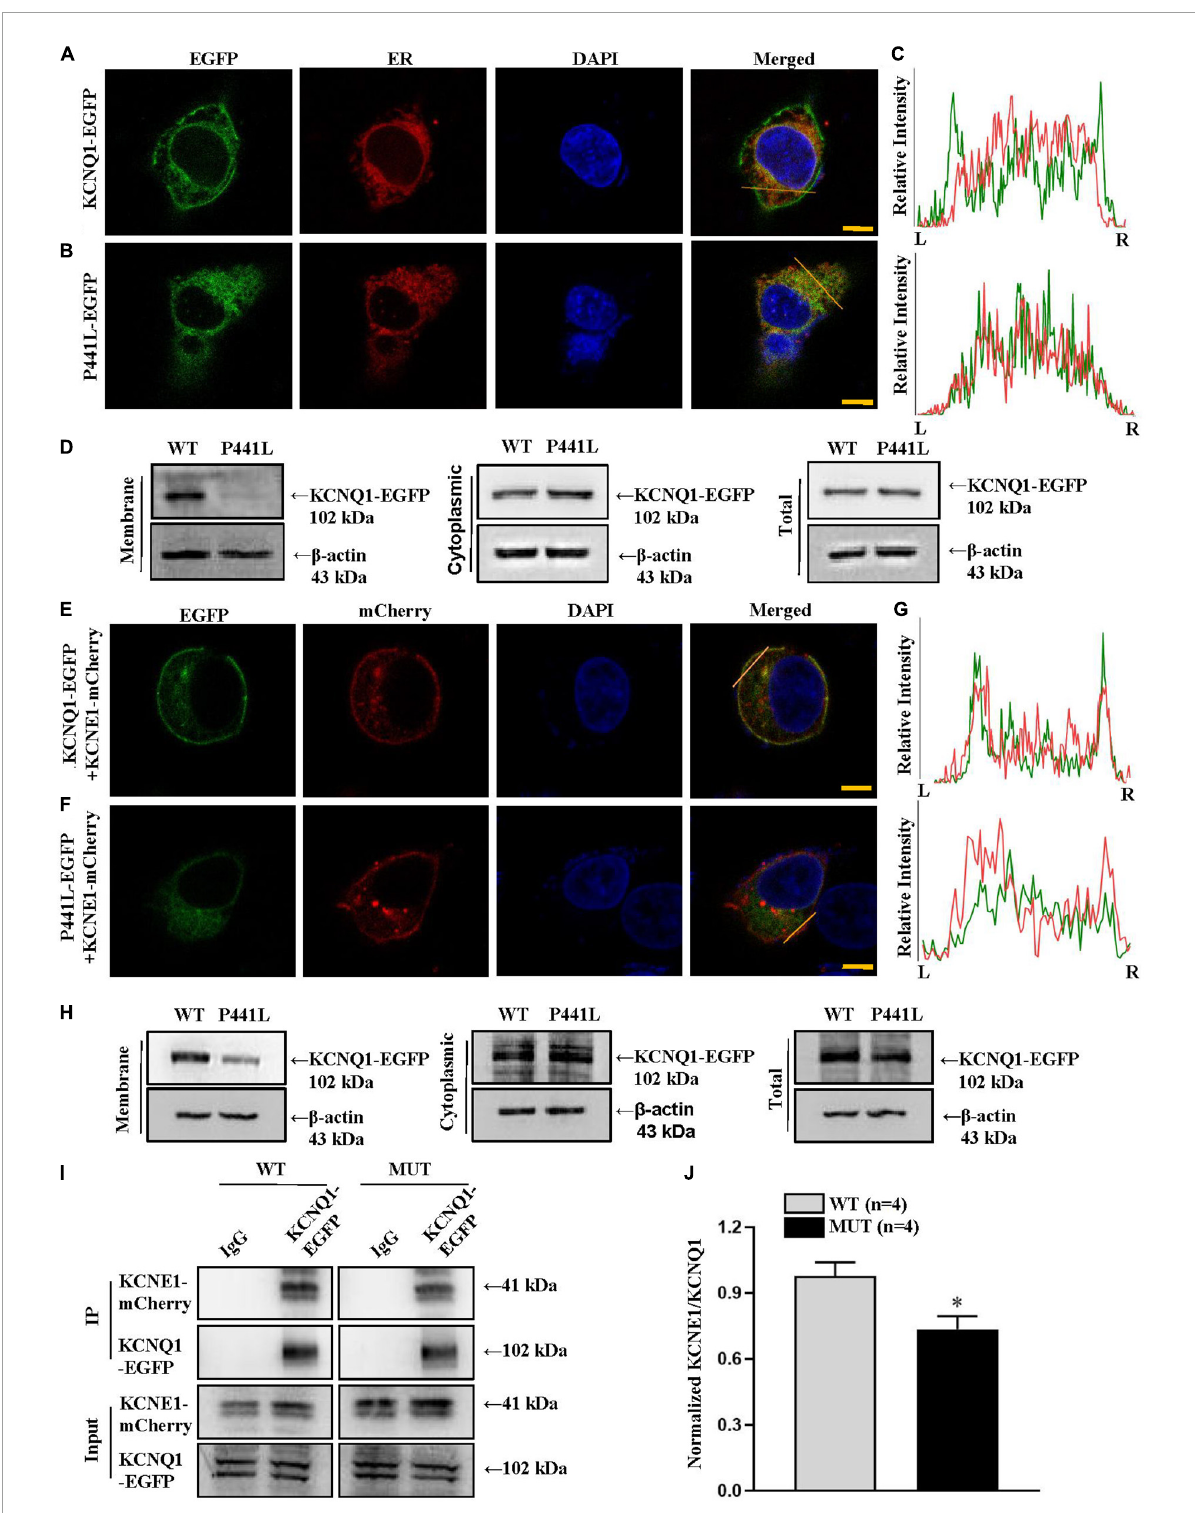
FIGURE2 KCNQ1 P441L variant protein trafficking in the absence or presence of KCNE1 (potassium voltage-gated channel subfamily E regulatory subunit 1), and the interaction between the KCNQ1 P441L variant and KCNE1 proteins. (A–C) Representative confocal microscopy images and line plots showing the cellular distribution of wild-type and P441L variant KCNQ1 proteins in HEK293 cells. Scale bar, 10 µ m. KCNQ1 was tagged with